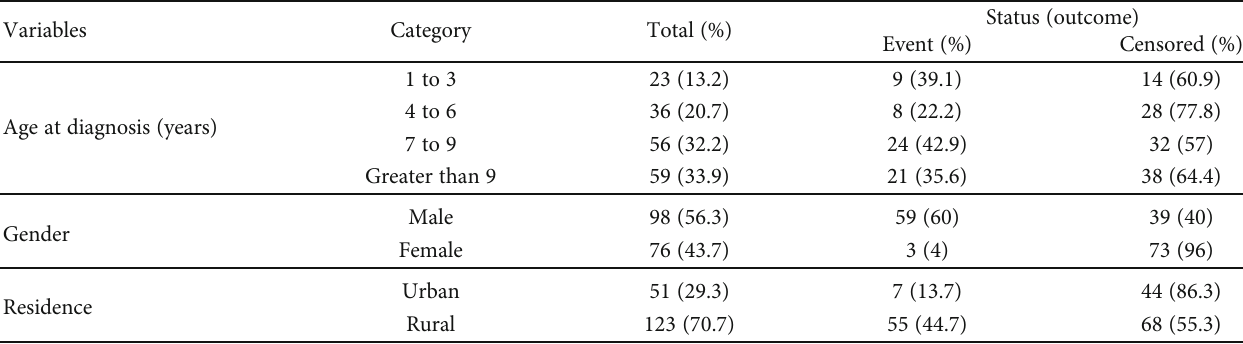
Table 1: Distribution of sociodemographic characteristics among children with nephrotic syndrome in comprehensive specialized hospitals of Tigray region, Northern Ethiopia, 2019 ( N = 174 ).